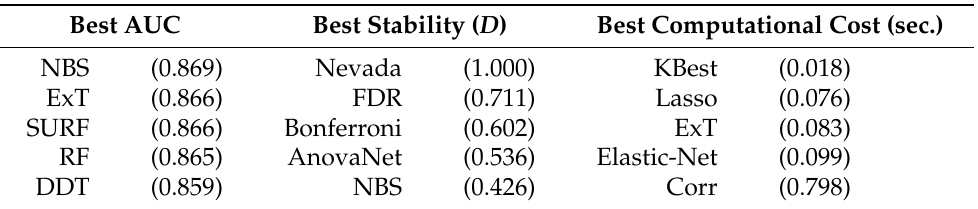
Table 1. Ranking of the top-5 methods, according to their AUC, stability D and computational cost, as obtained for the COBRE data